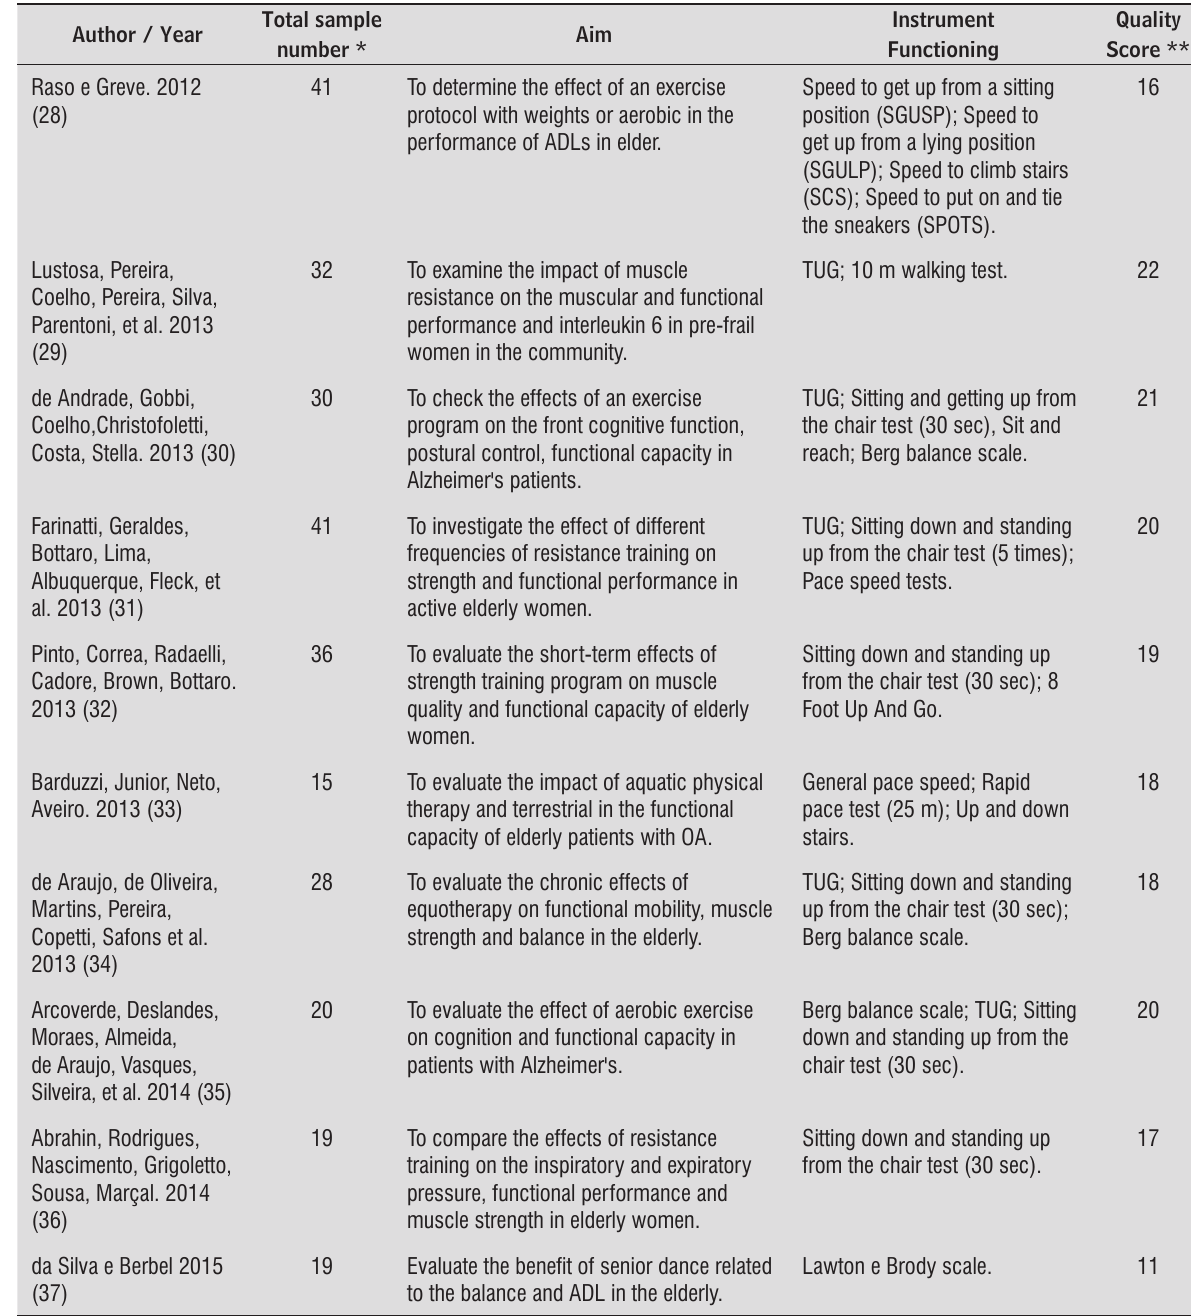
chair test, the TUG (Timed up and go test) and the 6 minutes walking test, showed in articles more fre- quently than others, twelve, nine, and six articles, respectively, as shown in Table